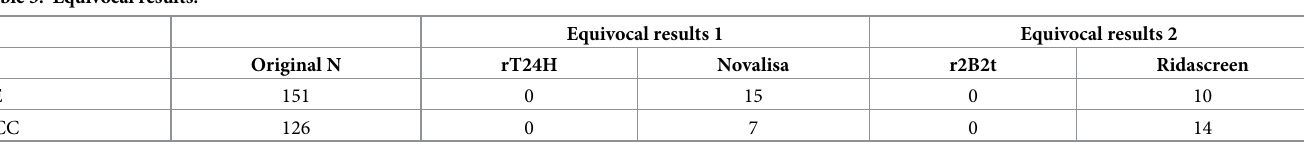
Table 3. Equivocal results.